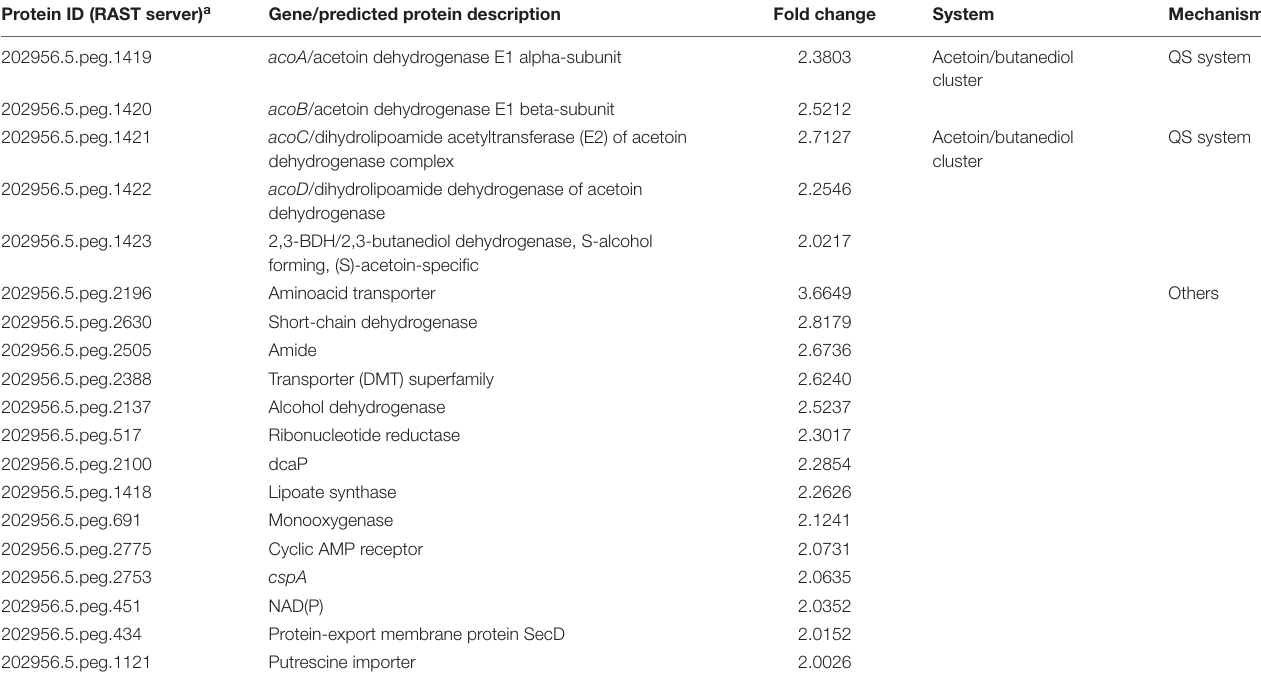
TABLE 4 | Expression of genes in Acinetobacter sp. strain 5-2Ac02 by quorum network molecules (3-oxo-C12-HSL). Protein ID (RAST server) a Gene/predicted protein description Fold change System